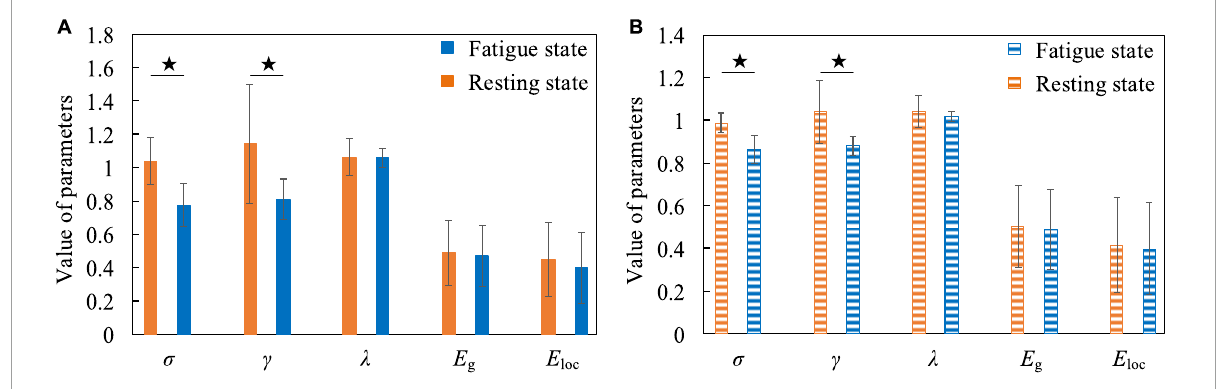
FIGURE8 The contrasting histograms of five global attribute parameters of functional brain networks in resting and fatigued states. “ (cid:70) ” indicates statistical difference, the same as below. (A) The case when the electroencephalogram (EEG) is at low frequency. (B) The case when the EEG is at high frequency.